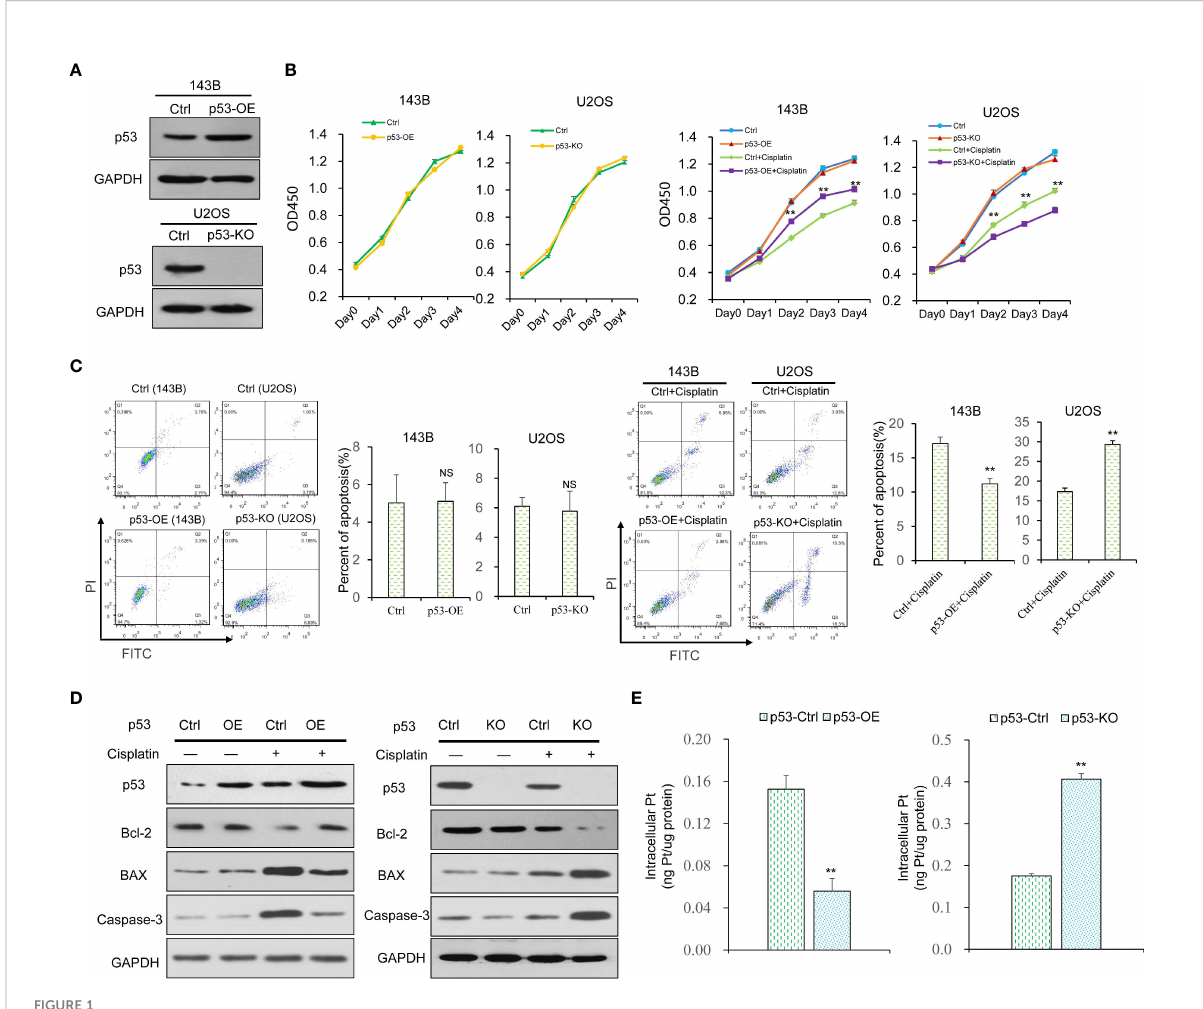
FIGURE 1 The effect of p53 on the viability, proliferation, apoptosis and cisplatin uptake in OS cells. (A) The p53 over-expression (p53-OE) 143B OS cell line was established by lentivirus-mediated infection, and p53 knock-out (p53-KO) U2OS OS cell line was built by CRISPR-cas9 gene editing technology. The expression of p53 was examined by western blot. GAPDH was used as the internal control. (B) Cell viability of p53-OE 143B cells and p53-KO U2OS cells treated with or without cisplatin (10 m g/ml) was determined by CCK8 assay. Data are representative of three independent experiments. (C) Cell apoptosis rate was detected by fl ow cytometry analysis using Annexin V and PI staining in p53-OE 143B cells and p53-KO U2OS cells treated with or without cisplatin (10 m g/ml). (D) The expression of apoptosis marker proteins in different p53-expressing OS cell lines with or without cisplatin incubation was determined by western blot. GAPDH was used as the internal control. (E) Cisplatin accumulation in p53-OE 143B cells and p53-KO U2OS cells treated with cisplatin (10 m g/ml) was detected by ICP-MS. Bars show mean ±